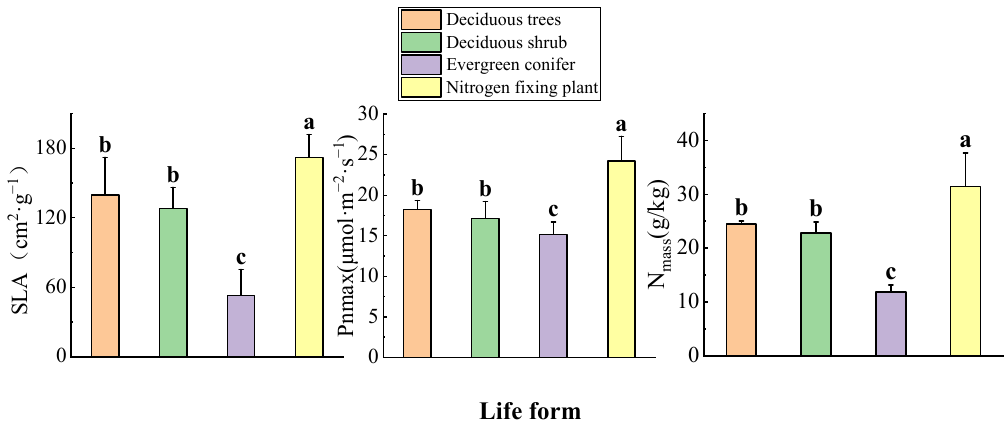
Figure 2. Comparison of mean value of maximum net photosynthetic rate (P nmax ), specific leaf area (SLA), and leaf nitrogen content (N mass ) between life forms (mean ± SE). Different small letters indicate significant difference between life forms for a given trait ( p < 0.05).